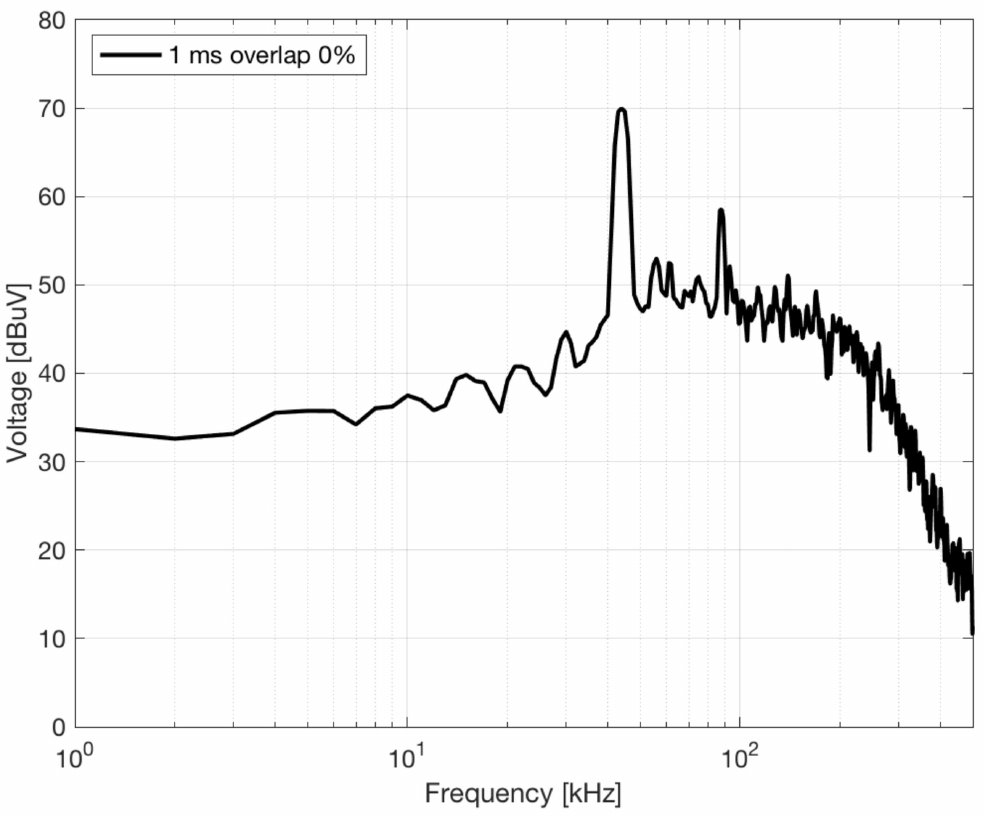
Figure 16. STFT spectrum with ∆ f = 1 kHz and time step ∆ t = 1 ms of the signal resulting from the composition of IMFs 2 to 4 extracted with